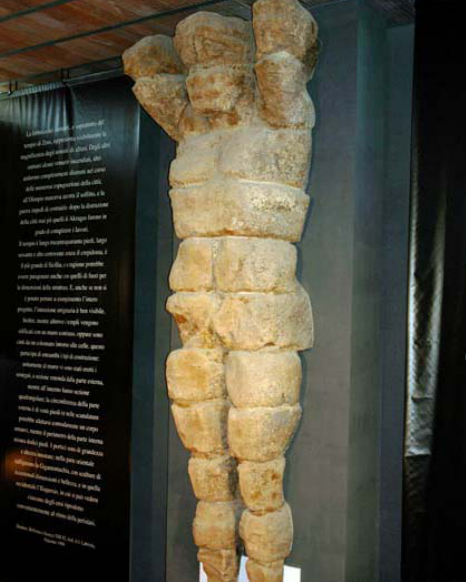
Figure 3. The Telamon in the Archaeological